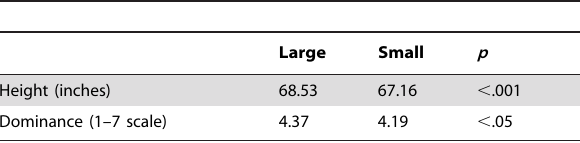
Table 2. Perceived size and status as a function of manipulations of environmental cues in Experiment